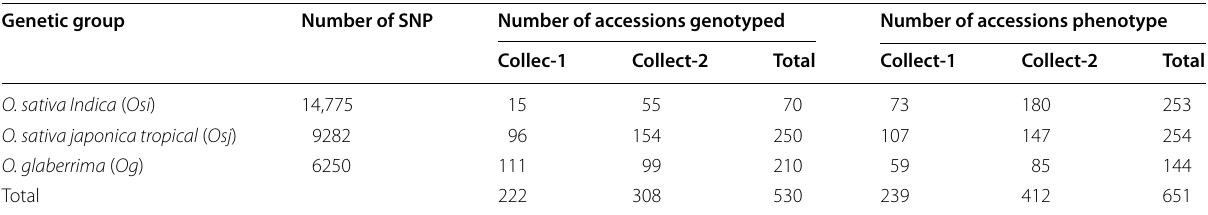
Table 1 Rice accessions from the two collect campaigns that were genotyped and/or phenotyped for the present study Genetic